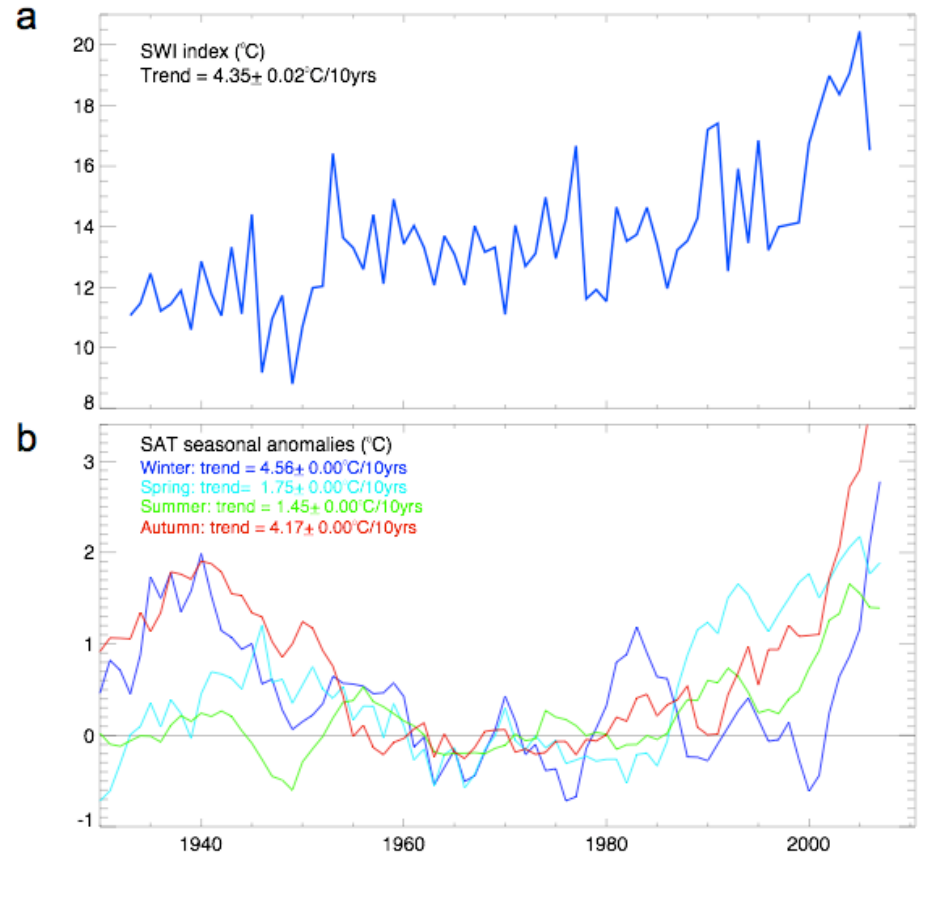
Figure 8. Time series of ( a ) SWI and ( b ) seasonal surface air temperature (SATs) anomalies for Eurasia based on 2-m air temperatures from meteorological stations (see locations in Figure A1b). Trends shown in the panels are for the period 1982–2008. The x-axis for both panels is shown at the bottom of the